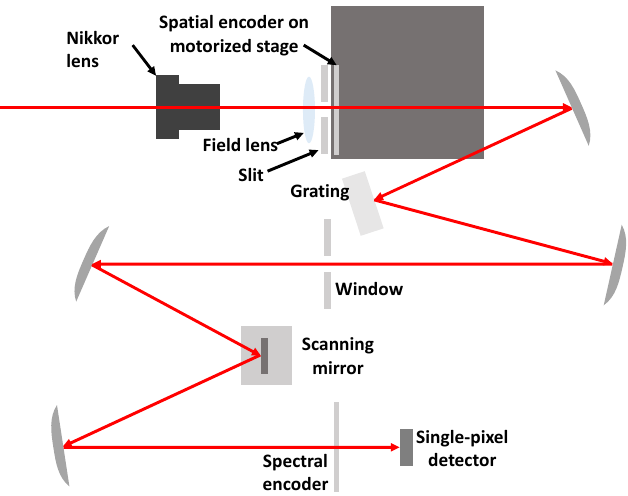
Figure 15. Schematic of a single-pixel hyperspectral imager in [149].